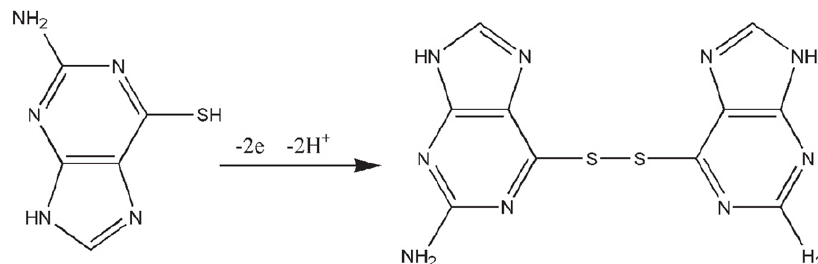
Scheme 1. Proposed mechanism for oxidation of 6-TG on the electrode.